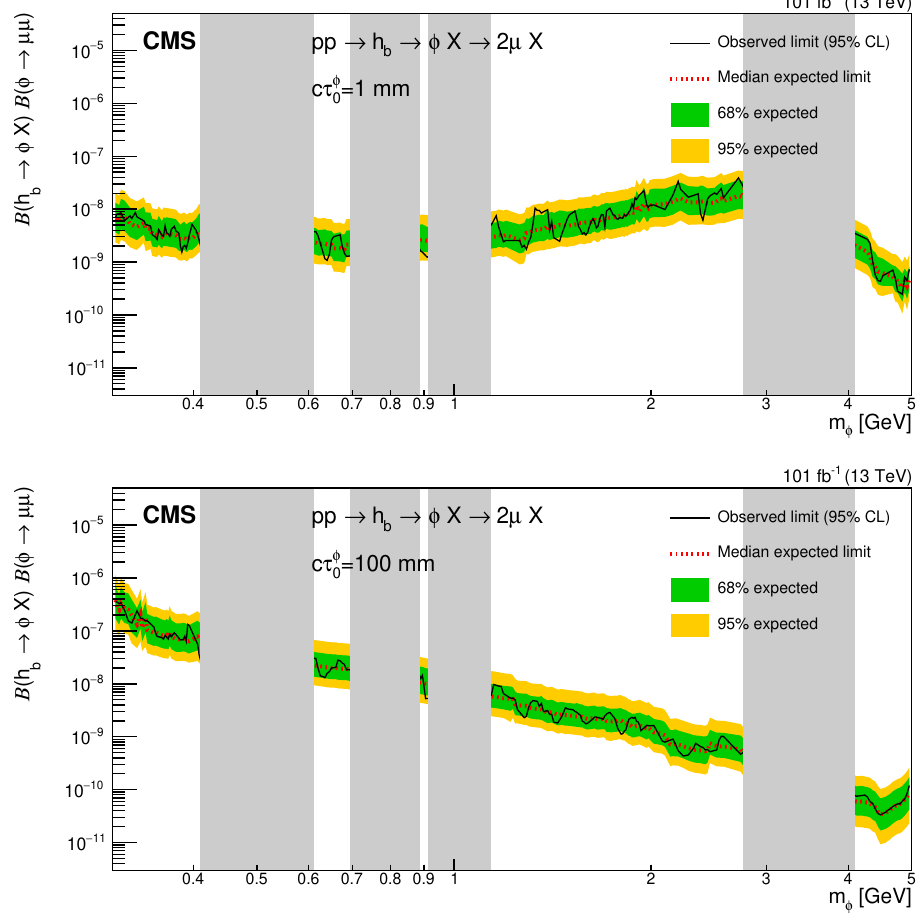
Figure 6 . Exclusion limits at 95% CL on the branching fraction product B ( h → φX ) B ( φ → µµ ) , b as functions of the signal mass ( m ) for cτ φ = 1 mm (upper) and 100 mm (lower). The solid black φ 0 (dashed red) line represents the observed (median expected) exclusion. The inner green (outer yellow) band indicates the region containing 68 (95)% of the distribution of limits expected under the background-only hypothesis. The vertical gray bands indicate mass ranges containing known SM resonances, which are masked for the purpose of this search. The limits are obtained using the combination of all dimuon event